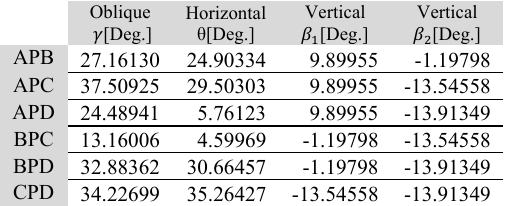
Table 7. Derived angles of the simulated test.